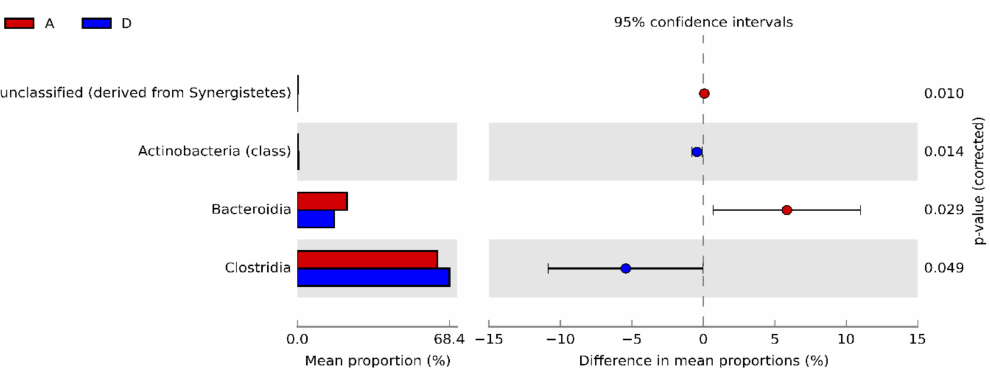
Figure 4. Bacterial classes resulting significantly di ff erent in synbiotic-fed broilers (group D) in comparison to untreated birds (group A) at 42 d.